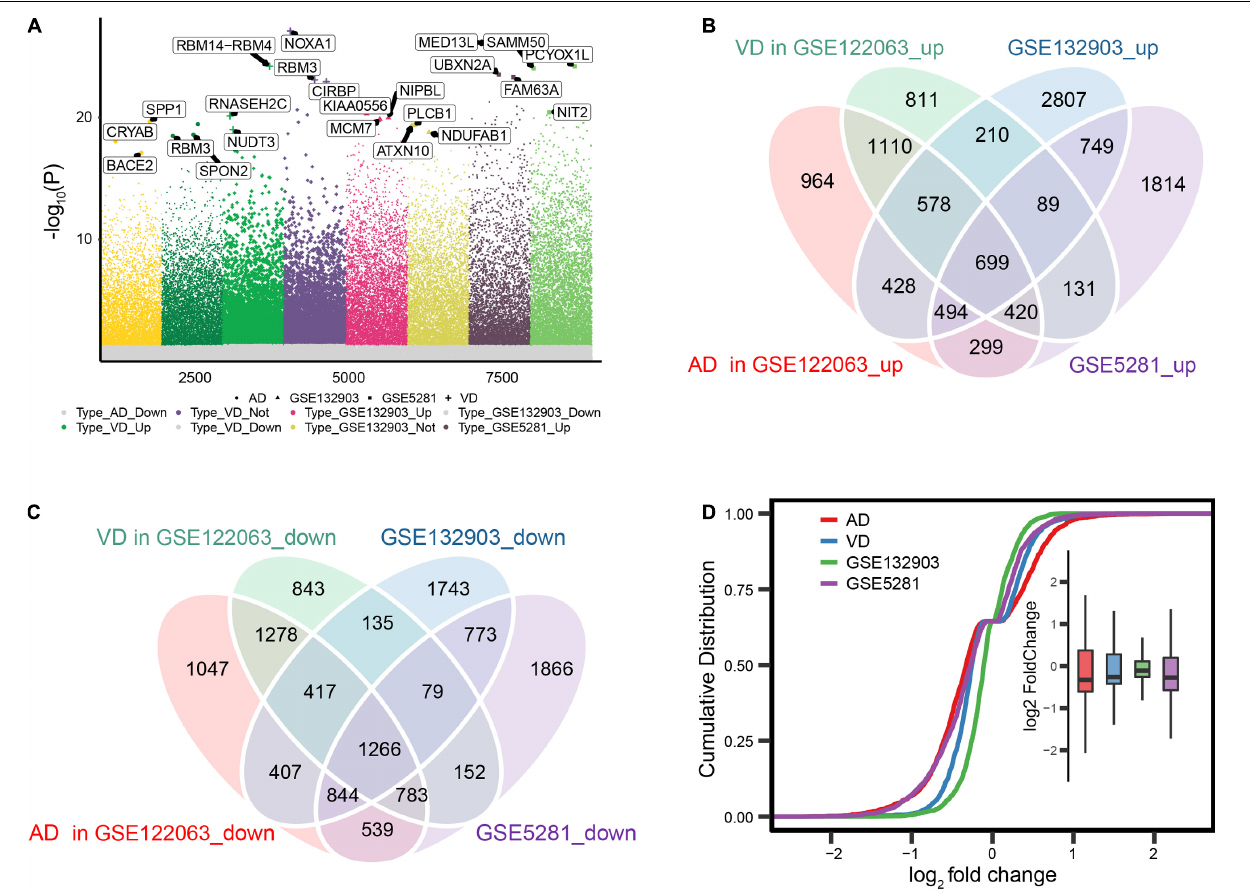
FIGURE 2 | Differential gene expression in Alzheimer’s disease (AD) and vascular dementia (VD). (A) Differentially expressed genes were identified between controls and patients with AD or VD in the datasets GSE122063, GSE132903, and GSE5281. (B, C) Overlap of differentially expressed genes that were up- or downregulated in the two disorders. (D) Cumulative distribution plots showing similarity in the expression of differentially expressed genes across datasets.